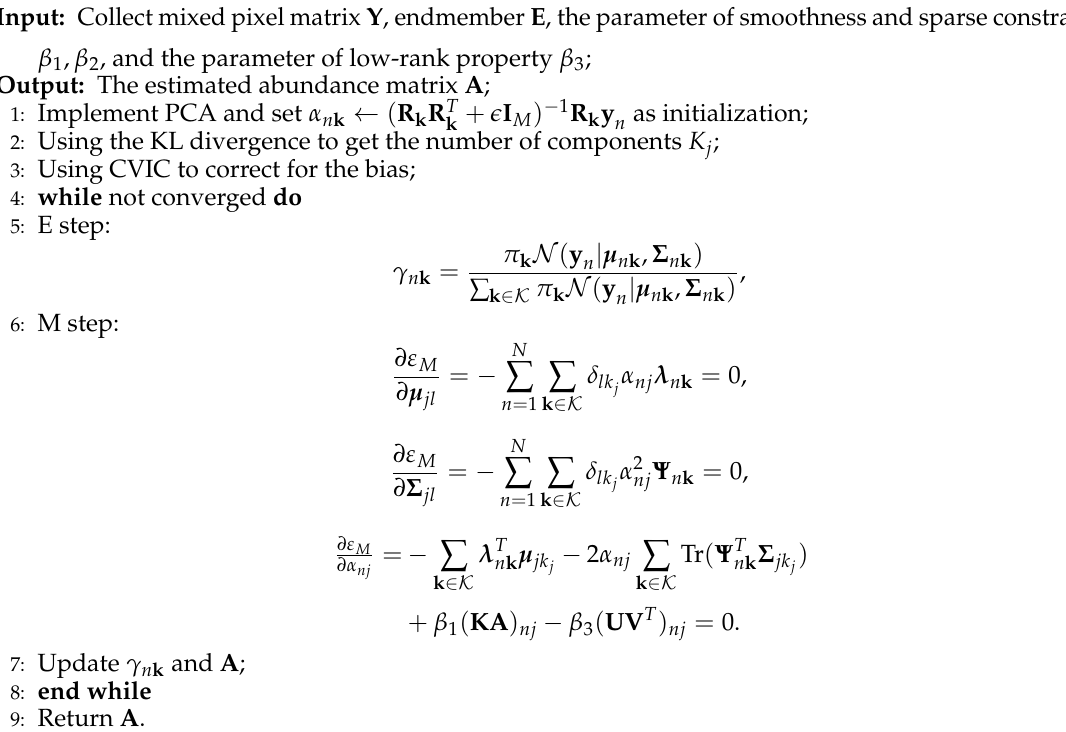
Algorithm 1 Solving Equation (15) with EM.